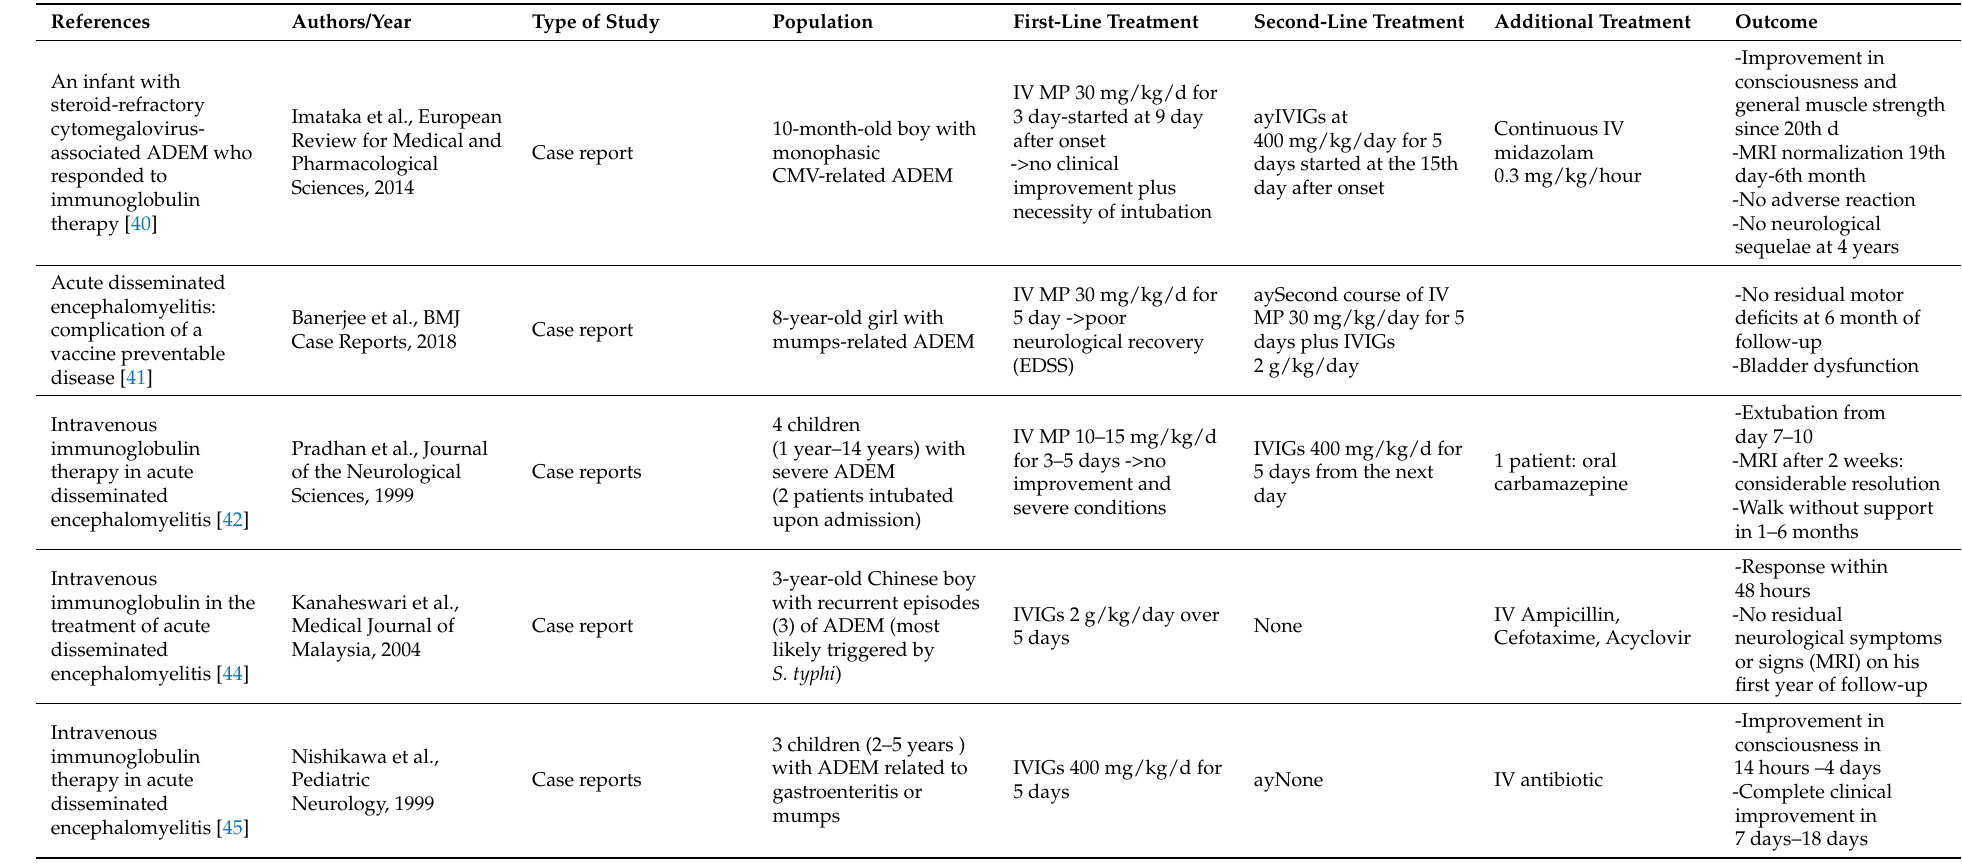
Table 5. Main pediatric studies on intravenous immunoglobulin (IVIG) therapy in in acute disseminated encephalomyelitis